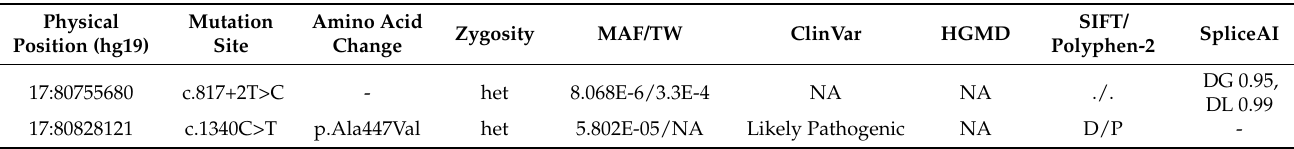
Table A1. List of identified pathogenic TBCD variants associated with early-onset neurodegenerative encephalopathy in this